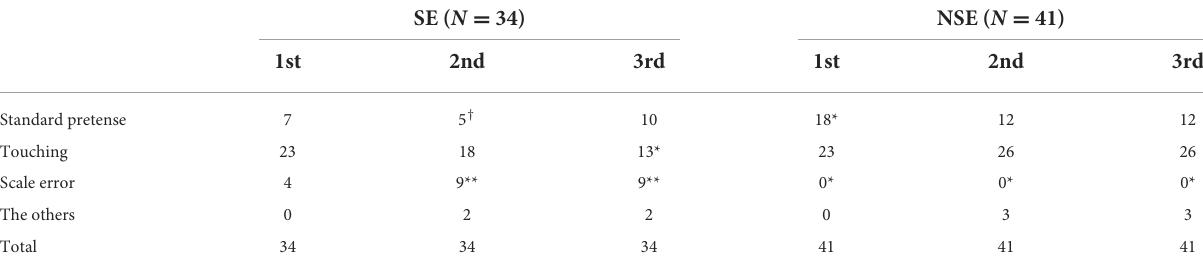
TABLE 4 Frequency of each play (standard pretense, touching, scale error, the others) at the first, second, and third times children of SE and NSE groups did from the start of task session. SE ( N = 34)